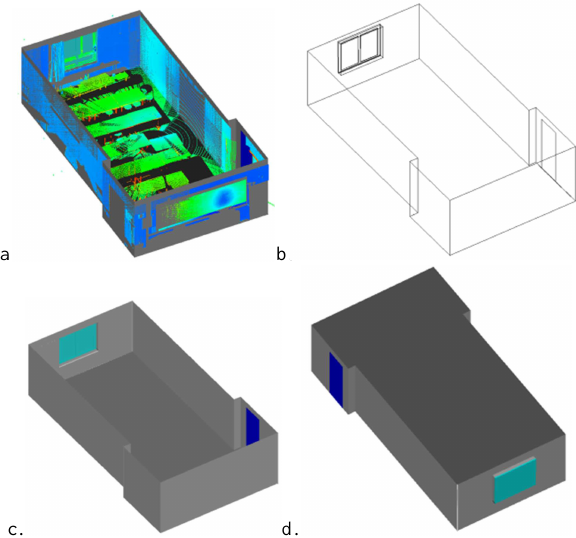
Figure 9. Geometric reconstruction of ‘Classroom’ data set: (a) room model with overlaid the original point cloud; (b) wireframe model of the reconstructed room; (c- d) final 3D room model from two different